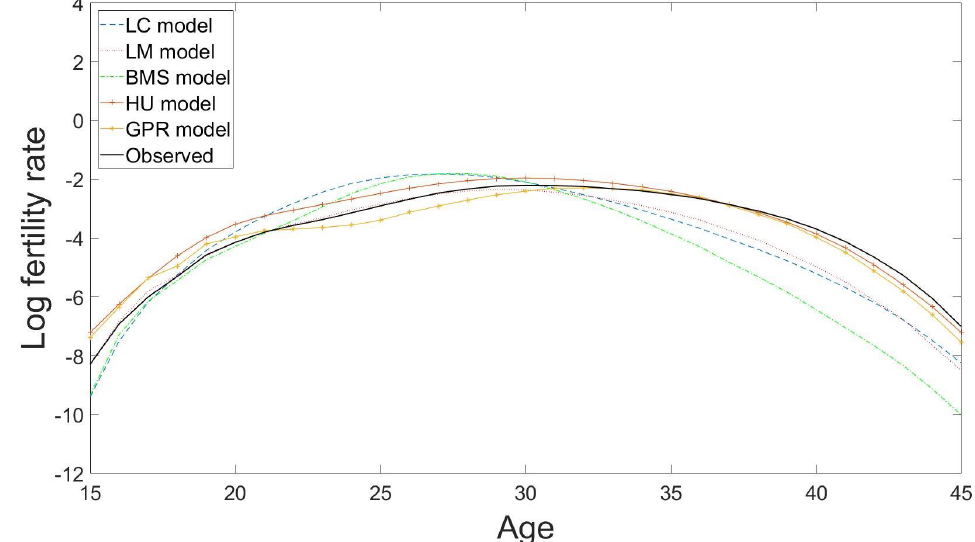
Figure 8. Predicted fertility curves from age 15 to age 45 for the year 2016 using the LC model (with RMSE = 0.9401), the LM model (with RMSE = 0.7490), the BMS model (with RMSE = 1.2198), the HU model (with RMSE = 0.4205) and the GPR model (with RMSE = 0.3764) based on the observations from the year 1947 to the year 2006 in